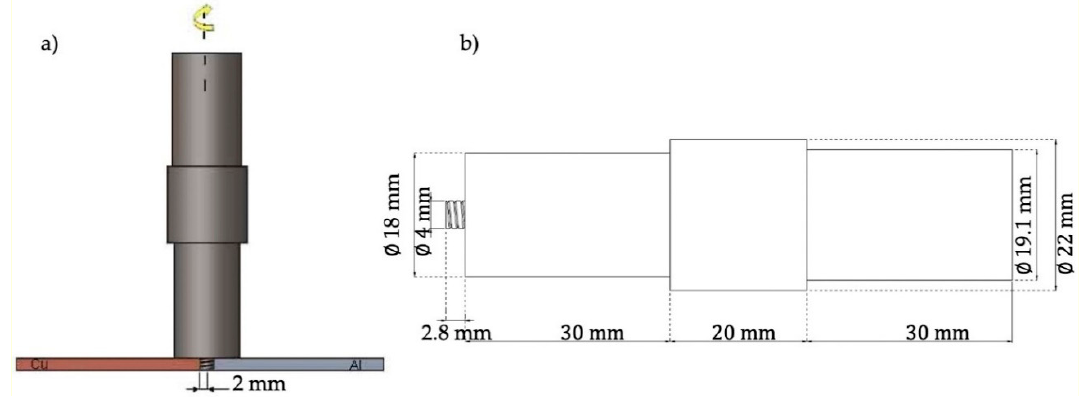
Figure 2. Schematic diagram of Friction Stir Welding (FSW) process. ( a ) configuration of the weld, ( b ) tool design. The rotational speed was of 1000, 1150, and 1300 rpm and the traverse speed of 20, 40, and 60 mm/min. The thermographic images were captured with a FLIR E40 thermographic camera to determine the heat input during welding. The different combinations of the parameters are presented in Table 2. Table 2. Different combination of parameters in the FSW of 6061-T6 and C11000 plates. Sample Rotational Speed (rpm) Traverse Speed (mm/min)